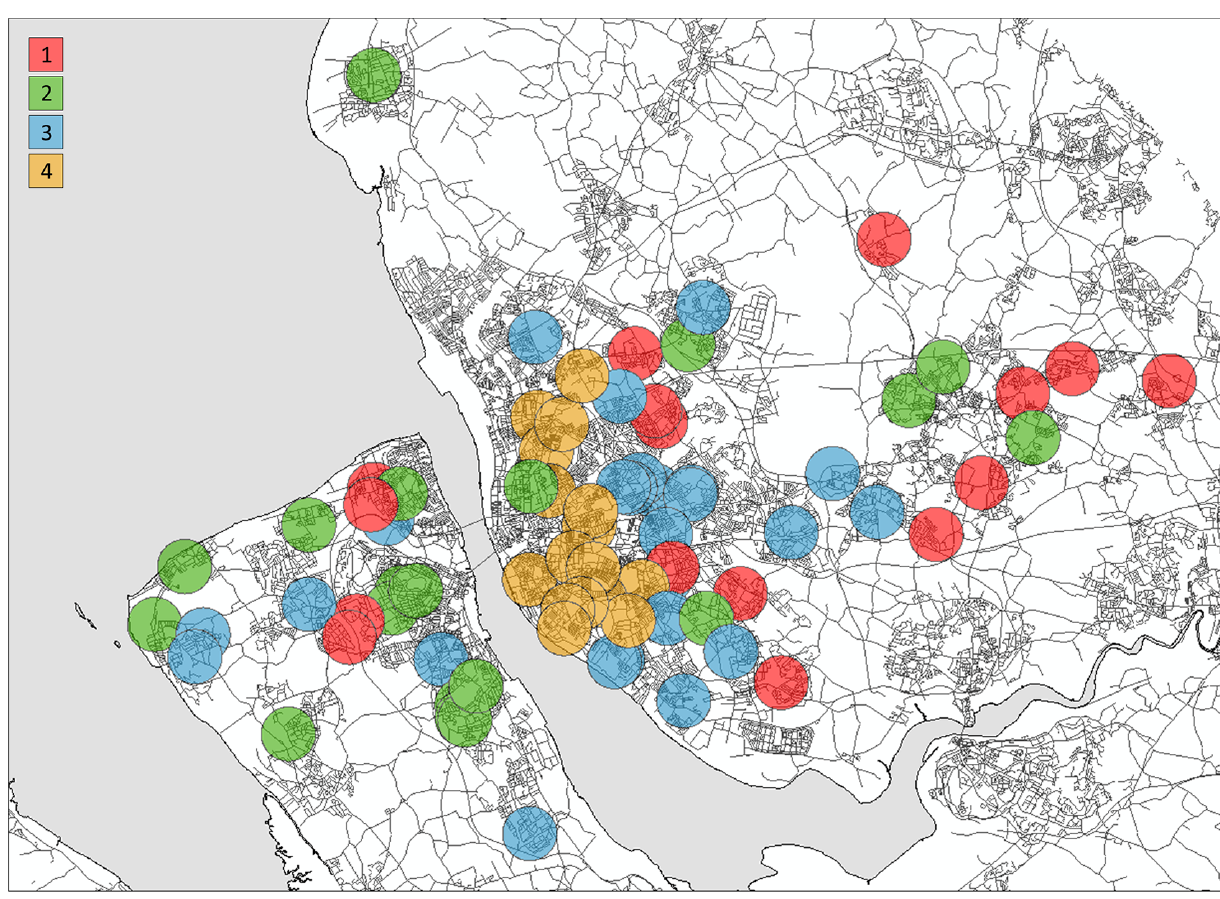
Figure 9. Geographical distribution of the four morphological